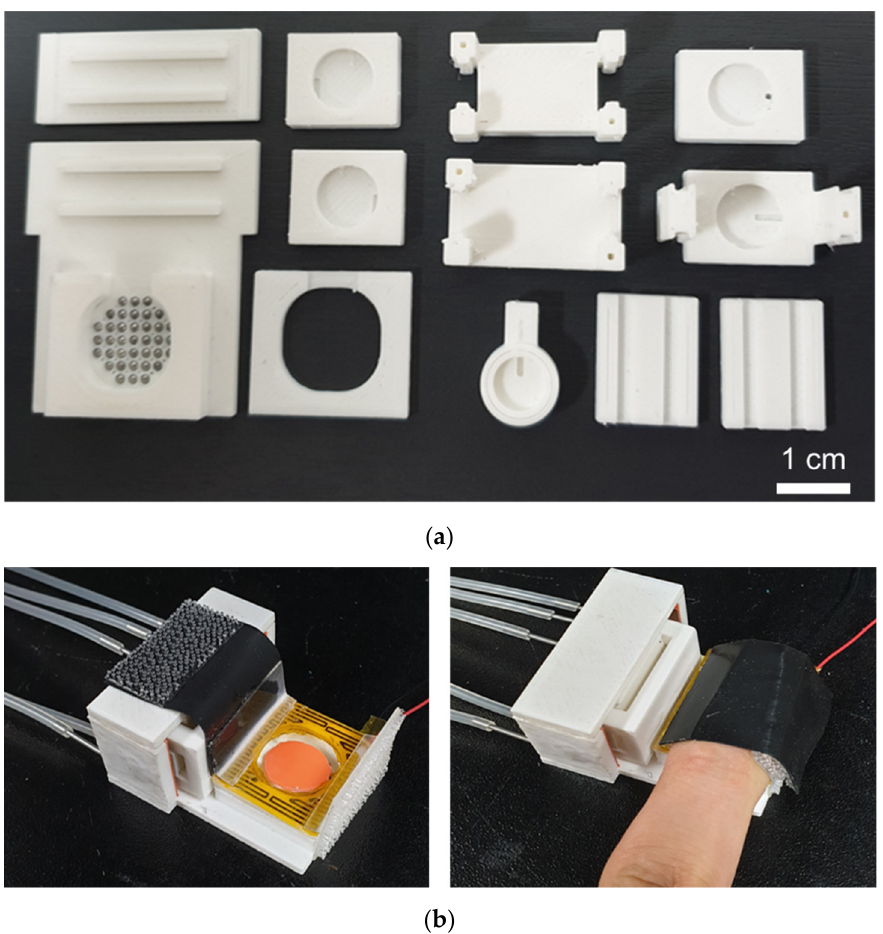
Figure 3. Photos of the haptic display. ( a ) Parts printed by a 3D printer for the haptic display; ( b ) A fully assembled haptic display and the device holding a finger.